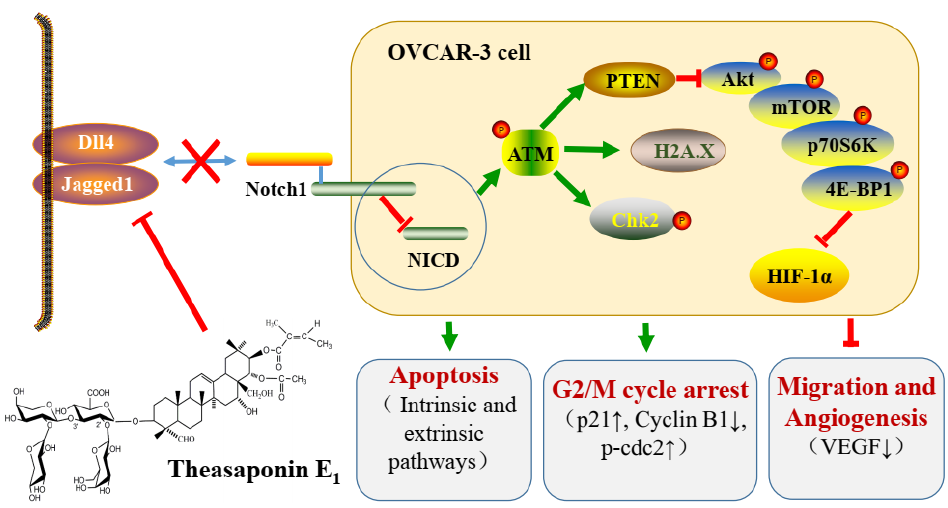
Figure 7. Schematic summary of the anticancer effect exerted by TSE1 on OVCAR-3 human ovarian cancer cells.